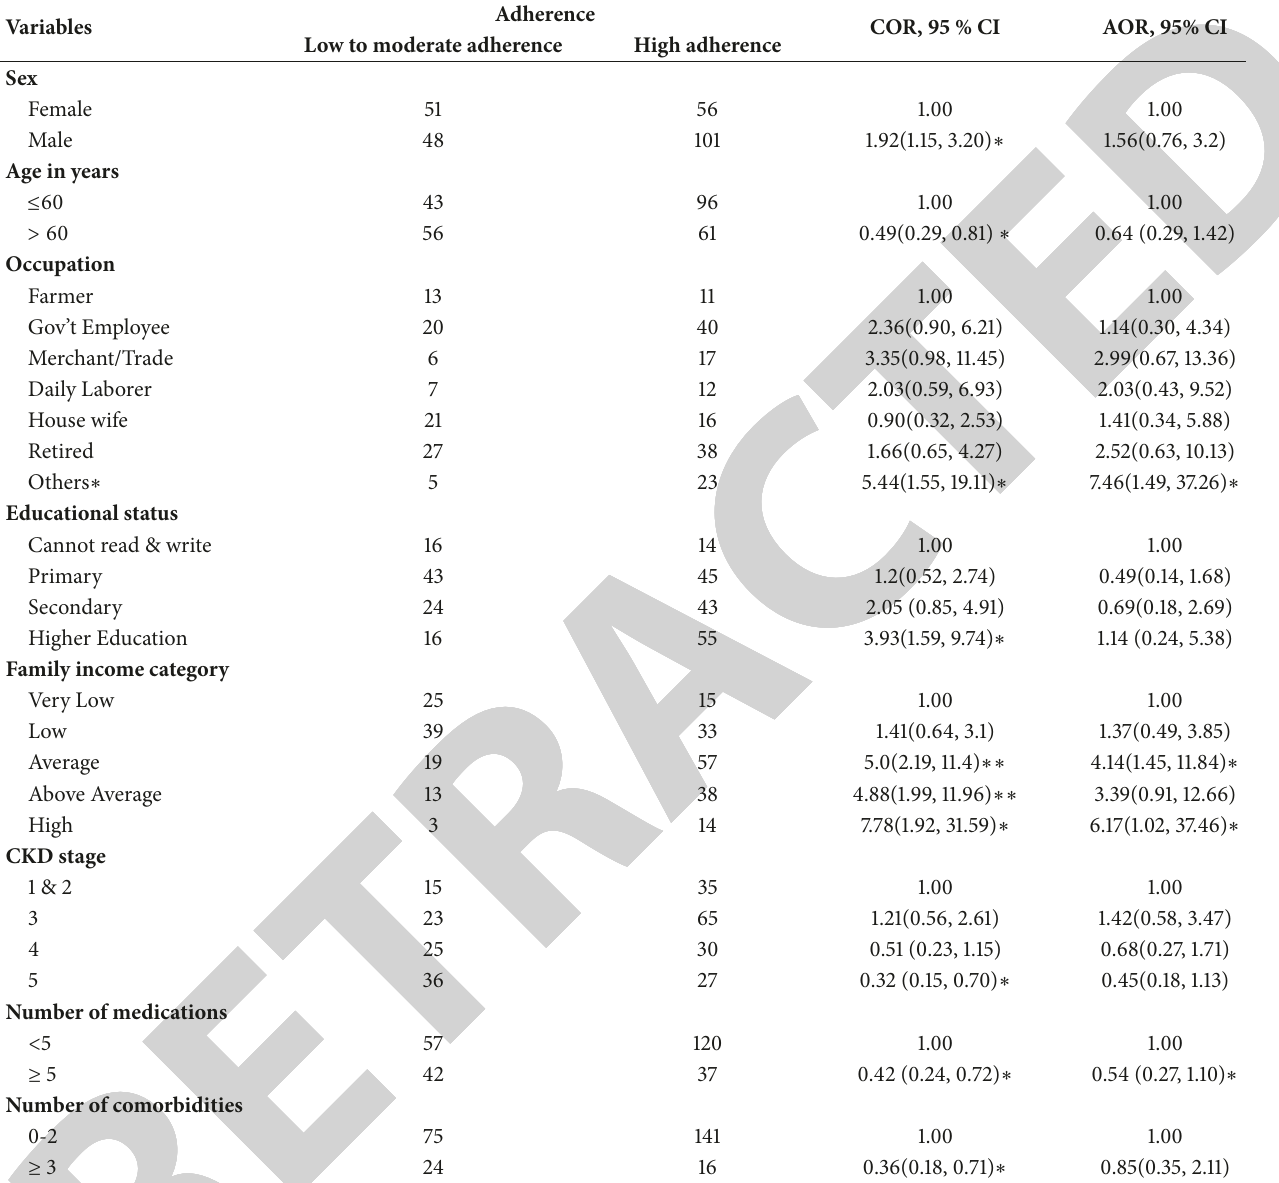
Table 7: Univariate and multivariate binary logistic regression analysis of predictors of medication nonadherence.